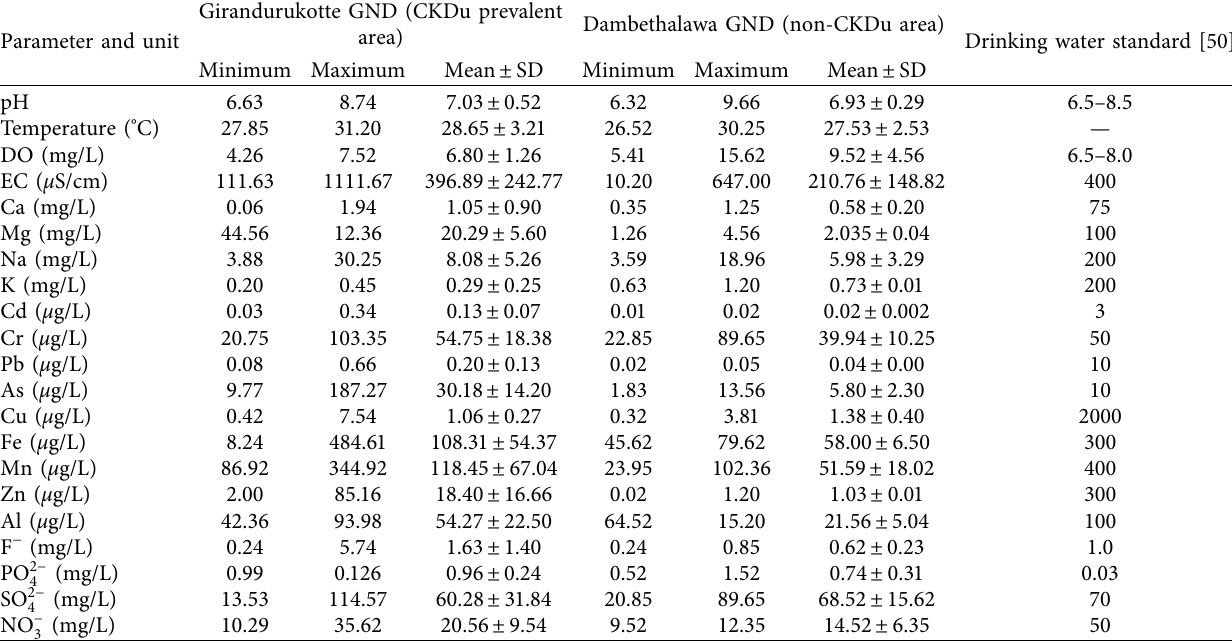
Table 4: Physicochemical data of collected drinking water samples from both CKDu prevalent and reference GNDs. Parameter and